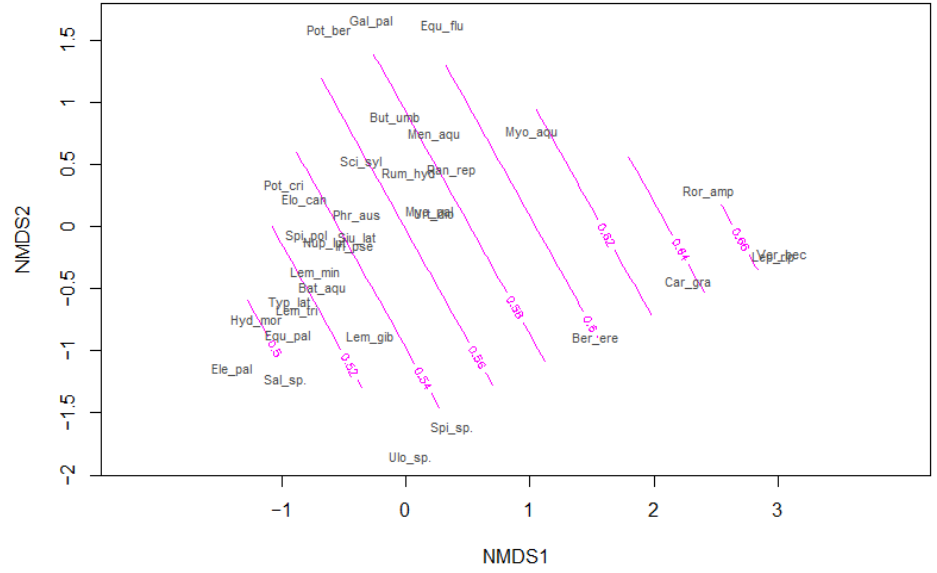
Figure 4. The influence of HIR on the occurrence of plant species. The HIR ranges from 0.50 to 0.66. The Shannon–Wiener index indicates a range of 1 to 3 points as moderately